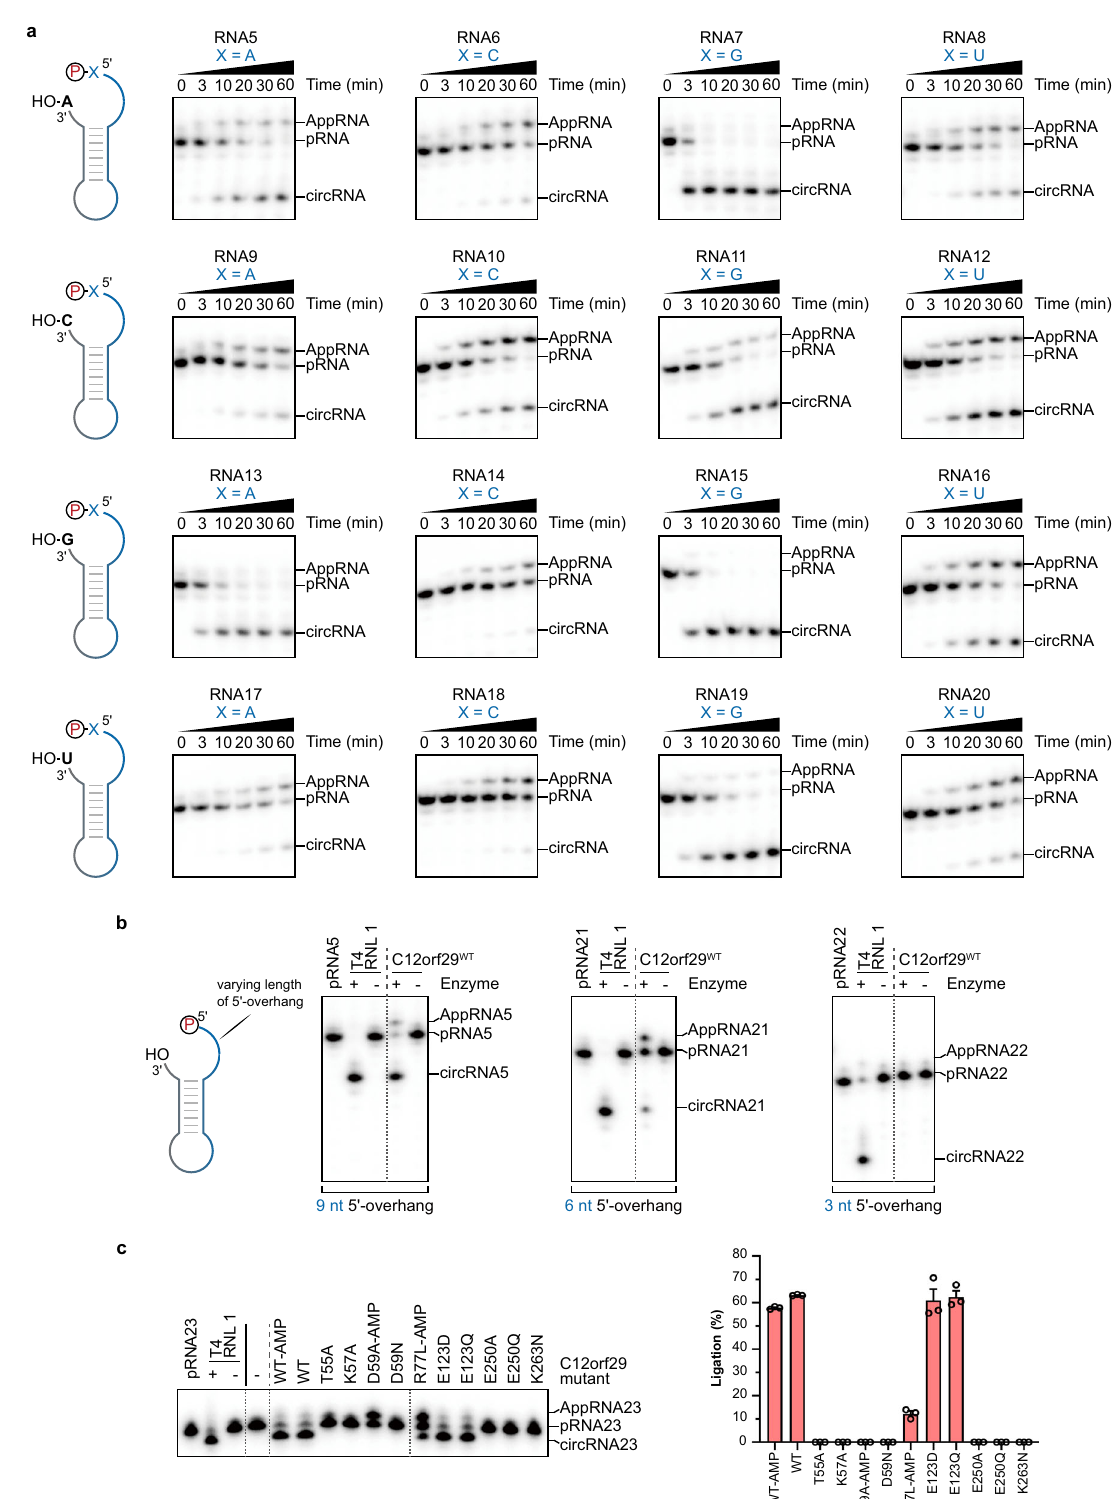
Fig. 4 | Substrate scope of C12orf29. RNA oligonucleotides that were used for intramolecular ligation resulting in cyclisation are schematically depicted. The 32 P-labelled 5 ′ -ends were depicted in red. The radioactive oligonucleotides were resolvedbydenaturingPAGEandanalysedbyphosphorimaging. a ,Investigationof the impact of the nucleobase composition at the 5 ′ - and 3 ′ - termini at the ligation site on the ligation ef fi ciency of C12orf29 (representative images of n =3). The depicted constructs were incubated under the same conditions for various time